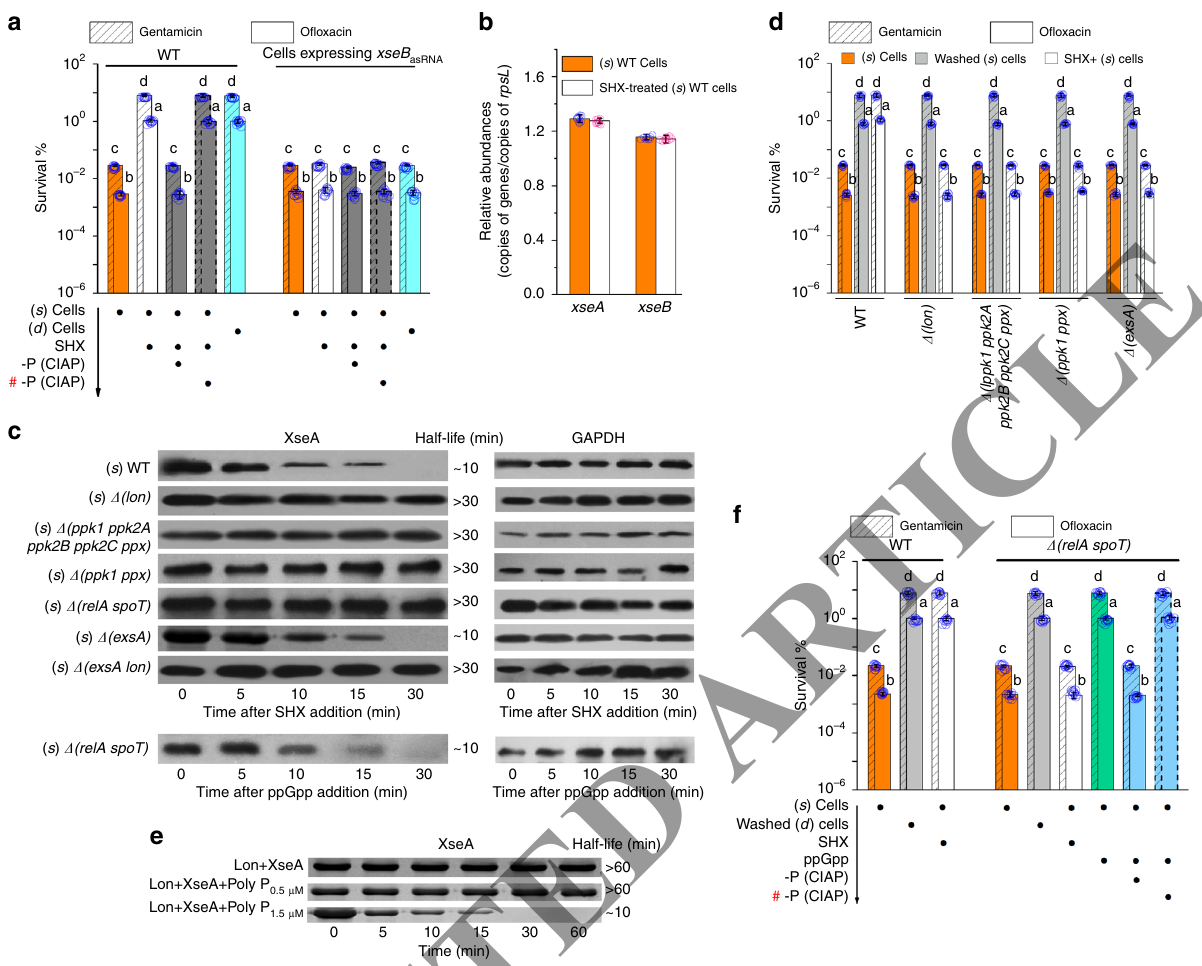
Fig. 4 Involvement of stringent response in induced persistence. a Persistence in ( s ) WT cells plus SHX and then alkaline phosphatase (CIAP) or in ( s )